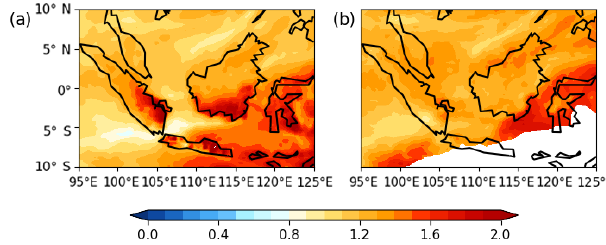
Figure 9. Ratio of simulated (a) surface PM 2 . 5 concentration and (b) AOD at 550nm from fires for September–October, when us- ing the surface injection option compared to the boundary layer in- jection option. Results are shown for the model with FINNpeatSM emissions. Zero values of average PM 2 . 5 and AOD have been re-